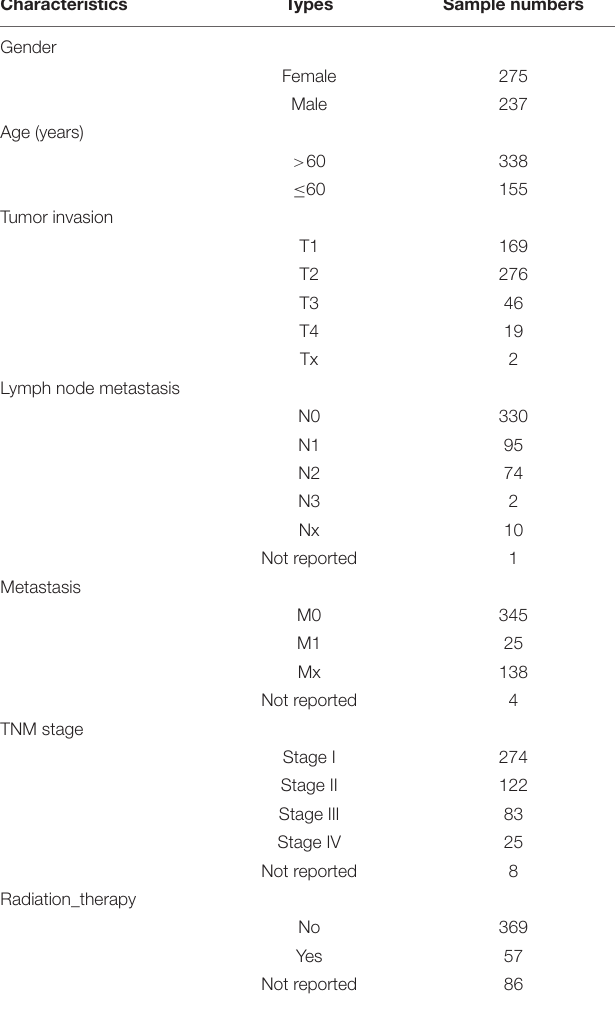
TABLE 2 | Patient and clinicopathological